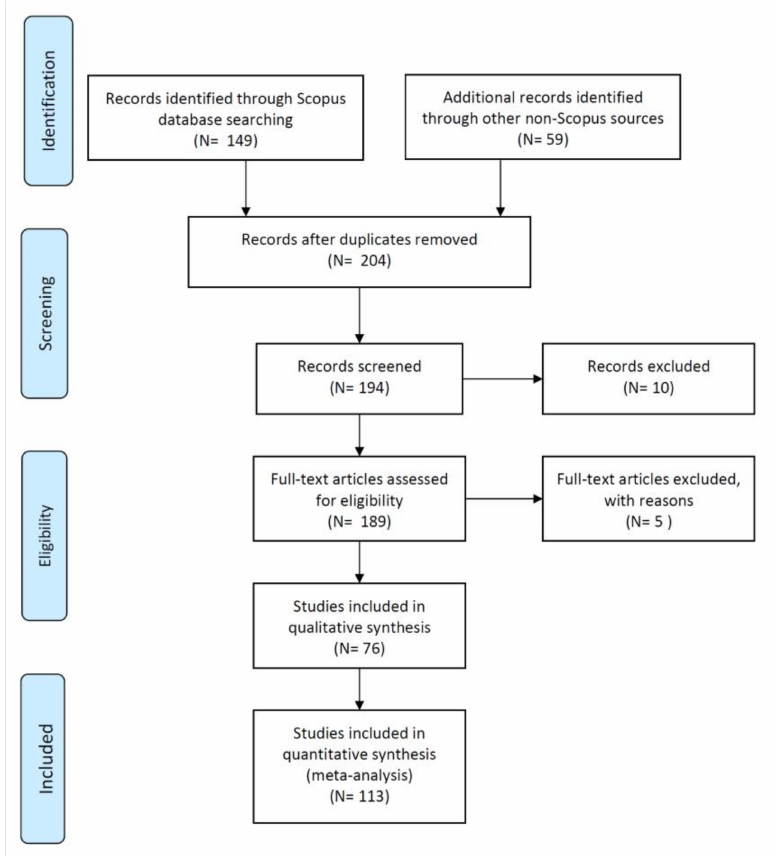
Figure 1. Flowchart of the Preferred Reporting Items for Systematic Reviews and Meta-Analyses (PRISMA) (adapted from Moher et al. [40]), used in the present